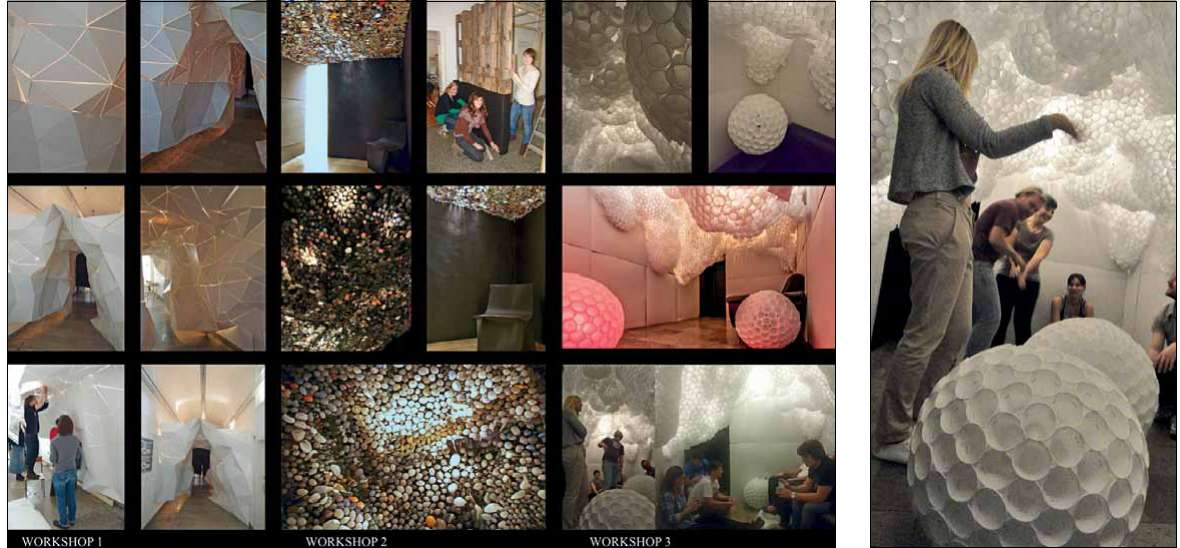
fig. 4. final model: Elements, materials and shapes – shaping the ambient. Source: fikfak (2010, 2011, 2013); photo: workshop